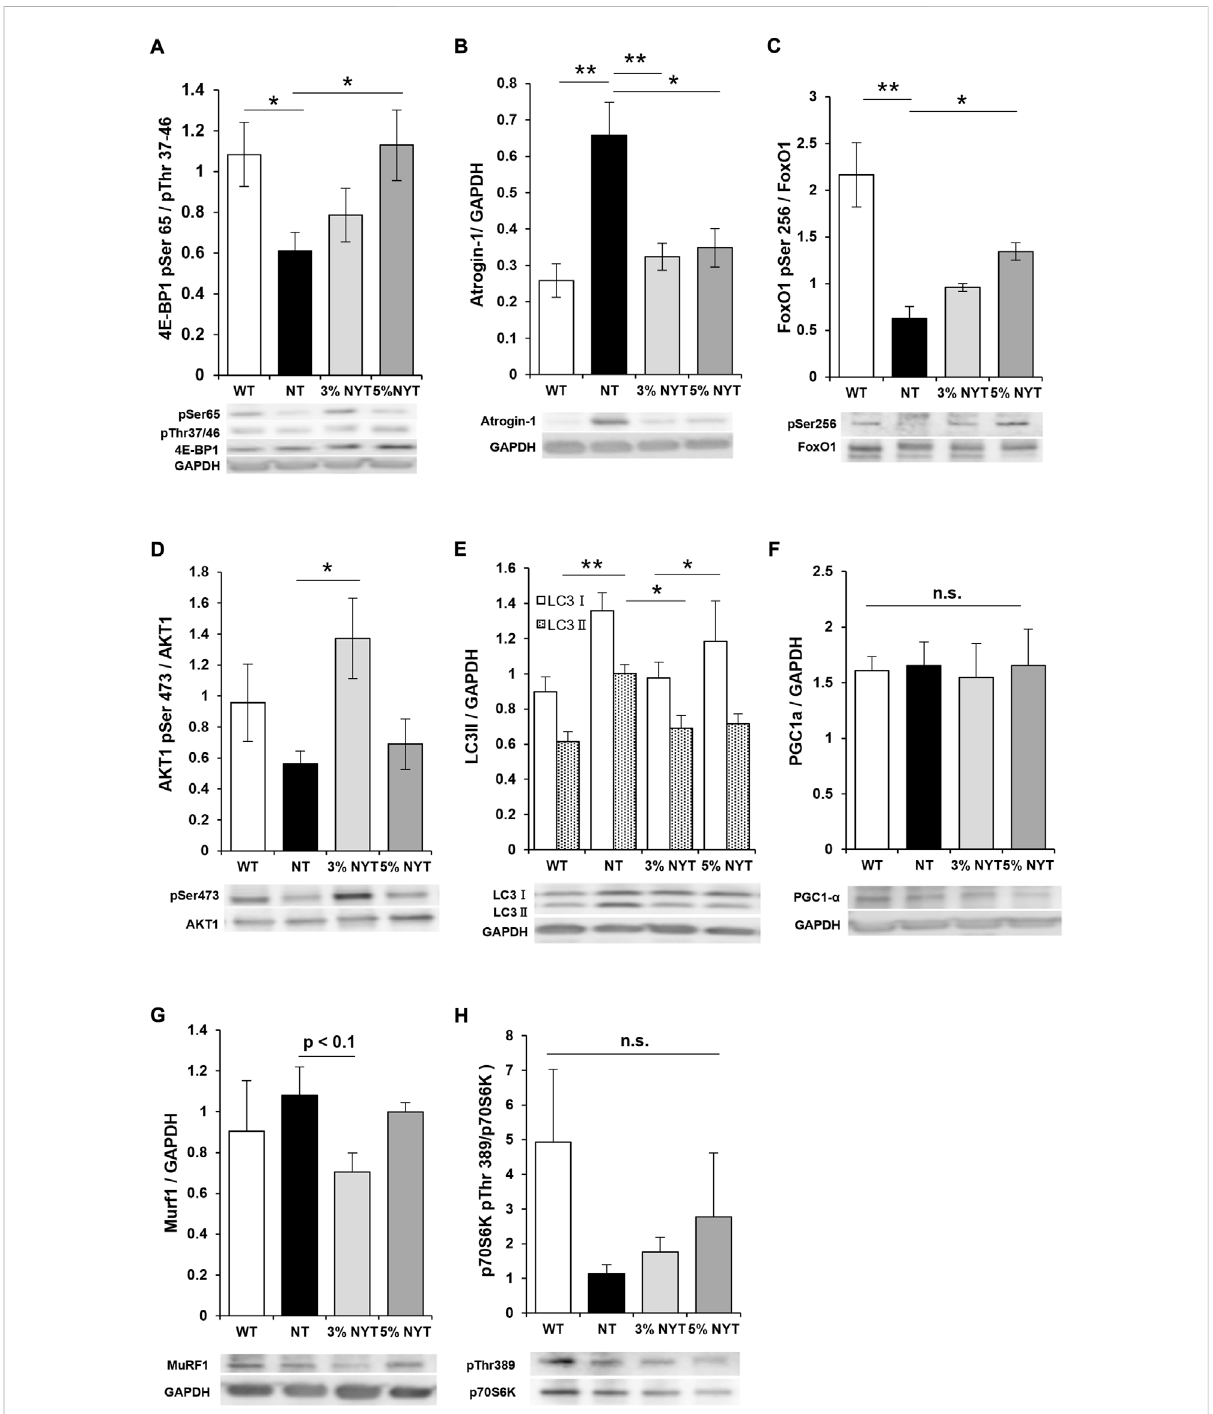
FIGURE 7 The activities of myoprotein synthesis factors and myoproteolytic factors in 59 days old were evaluated by western-blotting analysis using the dissected gastrocnemius muscle. The detected bands are shown below the graph of quanti fi ed arbitrary unit. Factors related to muscle protein synthesis: phosphorylation of AKT1 at Ser473 (D) , phosphorylation of 4E-BP1 at Ser65/Thr37-46 (A) , phosphorylation of p70S6K at Thr389 (H) , the amount ofPGC1 α (F) ;degradation-related factors: theamount of Atrogin-1 (B) , the amount ofMurf1 (G) , phosphorylationof FoxO1 Ser256 (C) , the amount of LC3II (E) . Data are indicated as mean and SEM values. Signi fi cant differences are presented on histograms: [* p < 0.05, ** p < 0.01, Dunnett ’ s contrast, WT ( n = 5), NT (8), 3% NYT (6), 5% NYT